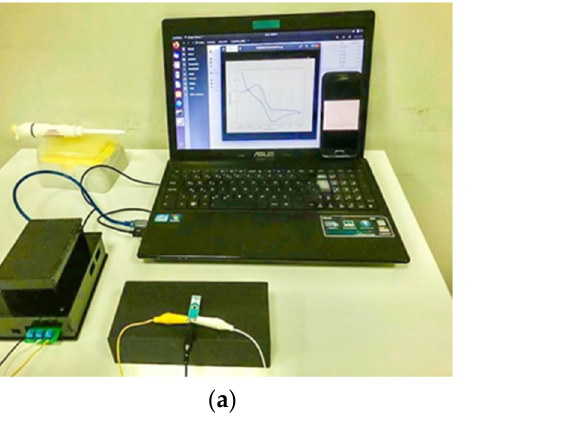
14 of 17 Figure 6. ( a ) Representative DPV peak forCRC plasma sample. ( b ) Representative DPV peak for control plasma sample. ( c ) mSEPT9 levels obtained from the developed sensor (***: p < 0.001) . Moreover, results were confirmed with RT-PCR and a methylated DNA quantifica- tion kit. All results are shown in Figure S10. In addition, the results obtained from differ- ent methods showed positive correlations with each other. According to the results, mSEPT9 levels were detected in more than 50% of patients above stage II, depending on the histopathological stage of colon cancer. However, no difference was found between male and female patients. The developed sensor was shown to successfully discriminate mSEPT9 in control and patient samples. A statistically significant difference was found between the control and patient groups ( p < 0.0001). 3.8. POC Device The designed potentiostat and its connection to the computer are shown in Figure S11. The obtained data can also be transferred to the smartphone via Bluetooth connection